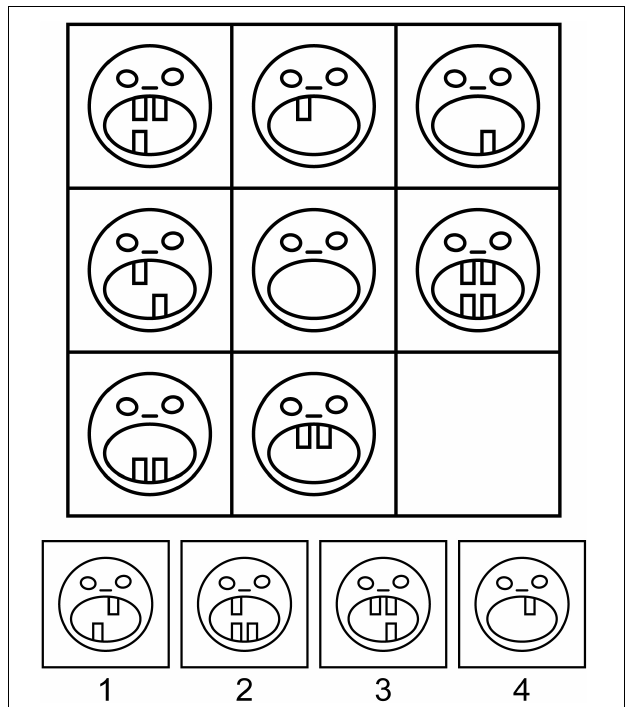
FIGURE 1 | A sample Raven-like matrix problem. Participants have to fill in the lower right corner of the visual matrix with one of the four alternatives by figuring out the principle of the matrix organization. Item created by Maria